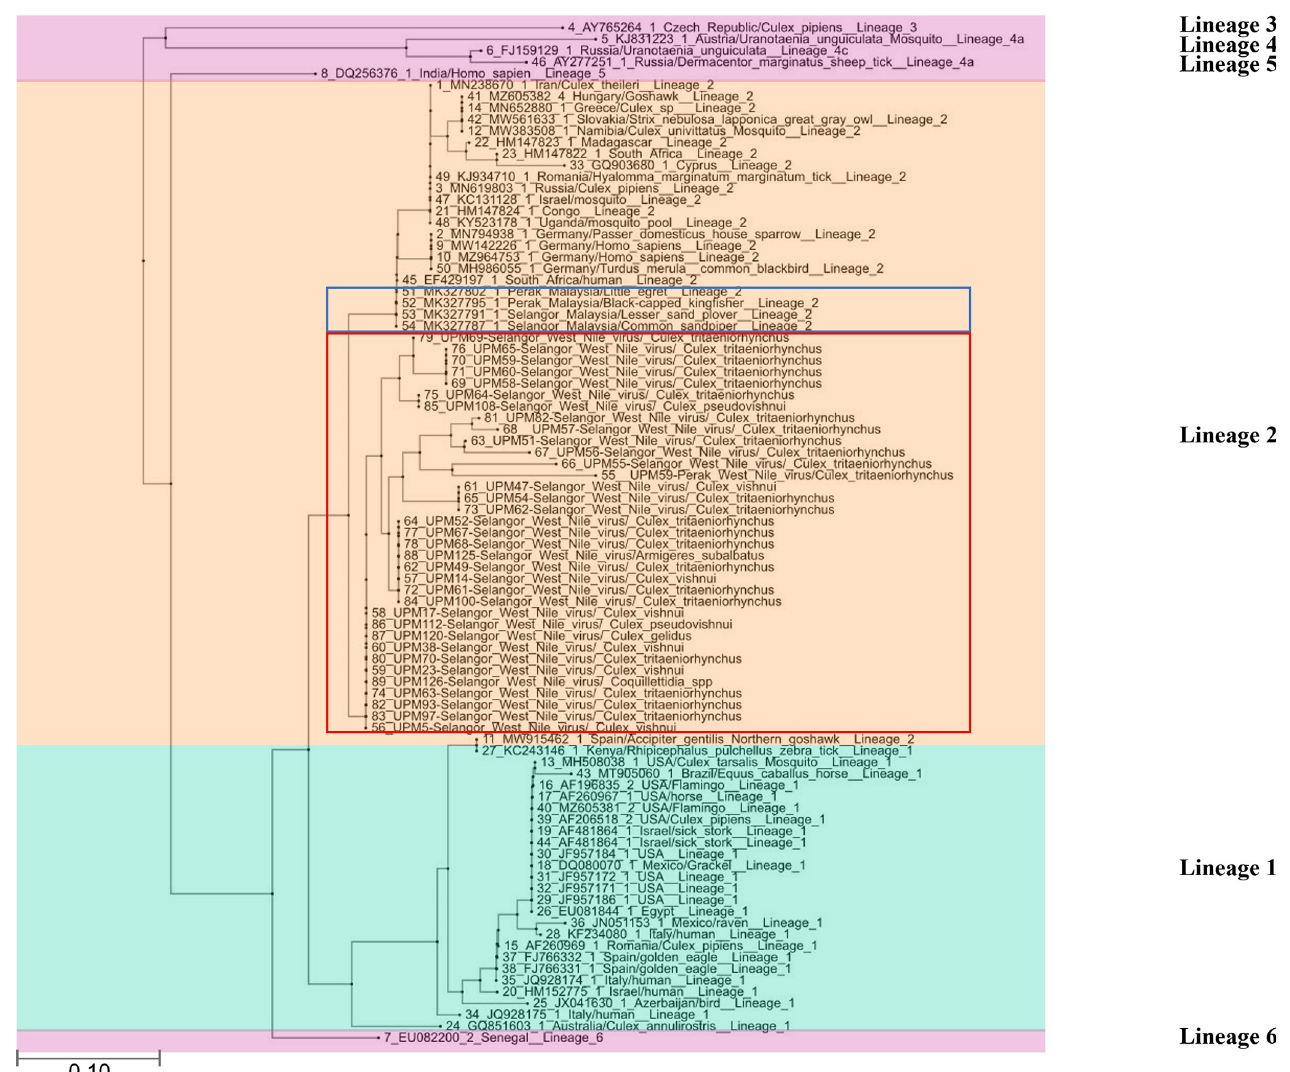
Fig 3. Phylogenetic analysis of WNV detected in the mosquito pools in Malaysia with other global WNV. The analysis includes 52 WNV nucleotide sequences from other countries, 4 WNV nucleotides sequences of wild birds from Malaysia (presented in the blue box) and 35 sequences from this study (presented in the red box). The tree branches are colored according to the proposed WNV lineages; green: Lineage 1; orange: Lineage 2; other lineages (3, 4a, 4c,5 and 6): purple. The tree was constructed using the maximum likelihood method with the Jukes-Cantor model with 1000 bootstrap replicate. Branches are scaled